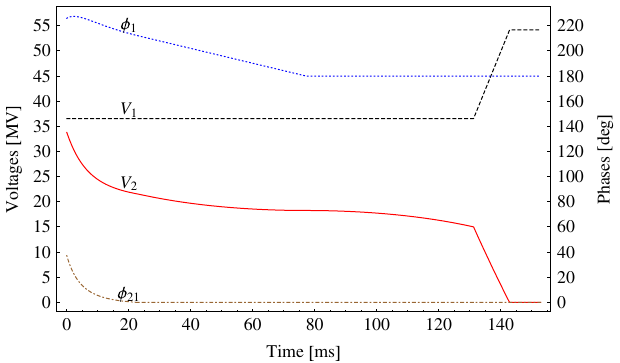
FIG. 42. Variations of the phases (in blue dotted for ϕ 1 and in brown dot-dashed for ϕ 21 ) and voltages (in red for V 1 and in black dashed for V 2 ) of the two cavity families during the rf program for